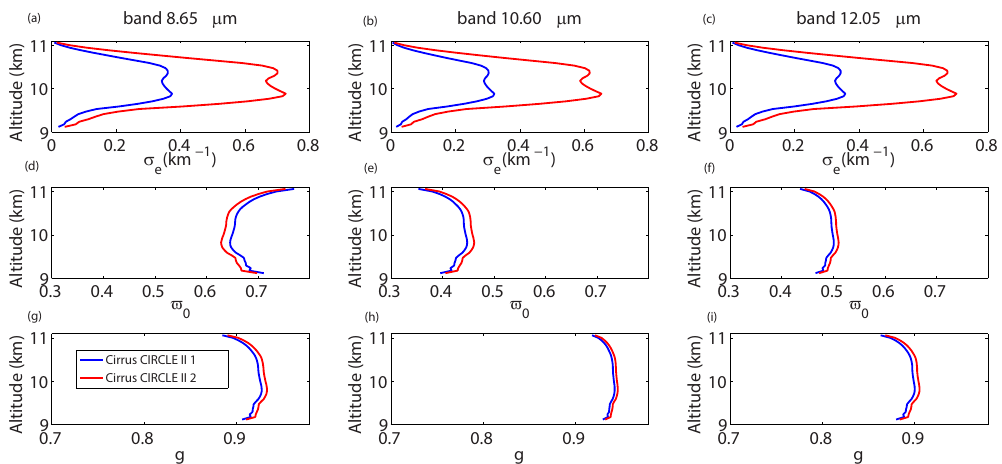
Figure 5. (a) , (b) and (c) : vertical variation of the mean extinction coefficient σ e ; (d) , (e) and (f) : vertical variation of the single scattering albedo $ 0 ; and (g) , (h) and (i) : vertical variation of the asymmetry factor g for the three channels at 8 . 65µm, 10 . 60µm and 12 . 05µm and for the cirrus CII-1 (blue curves) and CII-2 (red